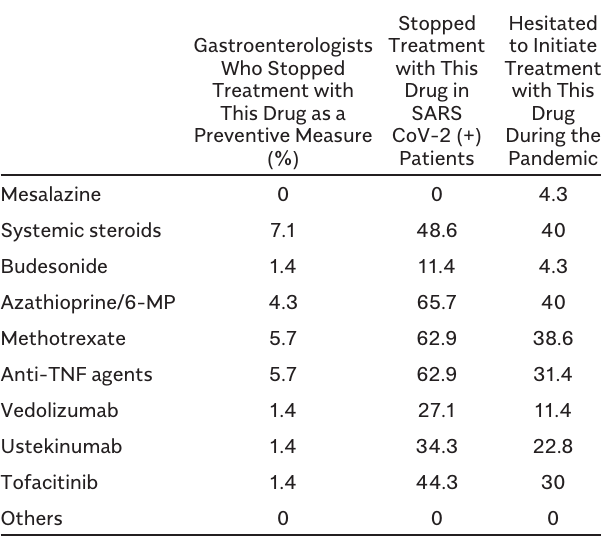
Table 4. Medications Stopped During the Pandemic Depending on SARS CoV-2 Positivity in IBD Patients